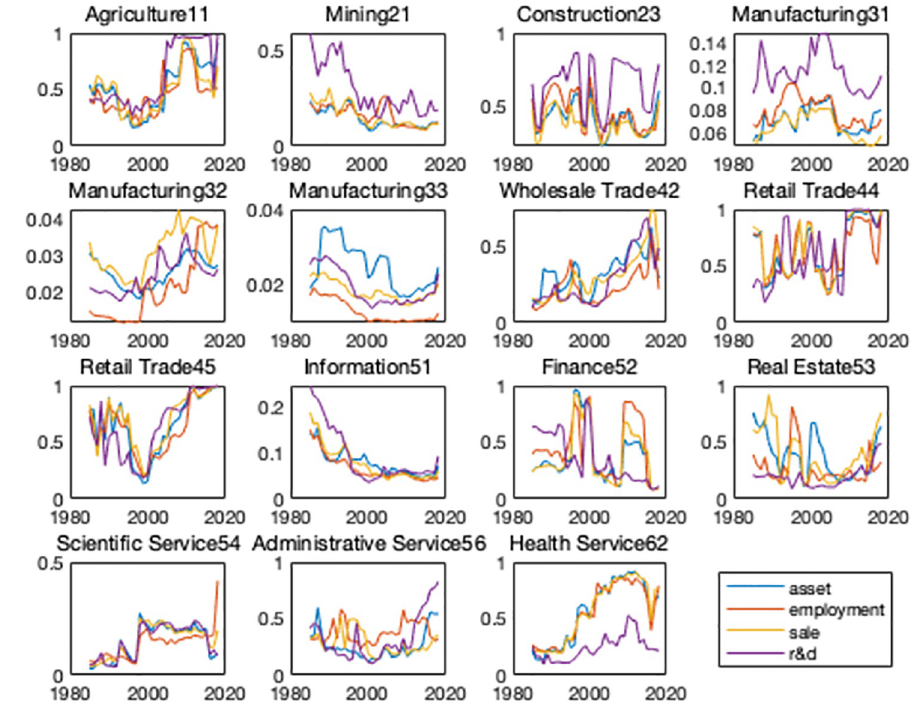
Fig 8. Industry-level HHI of product and